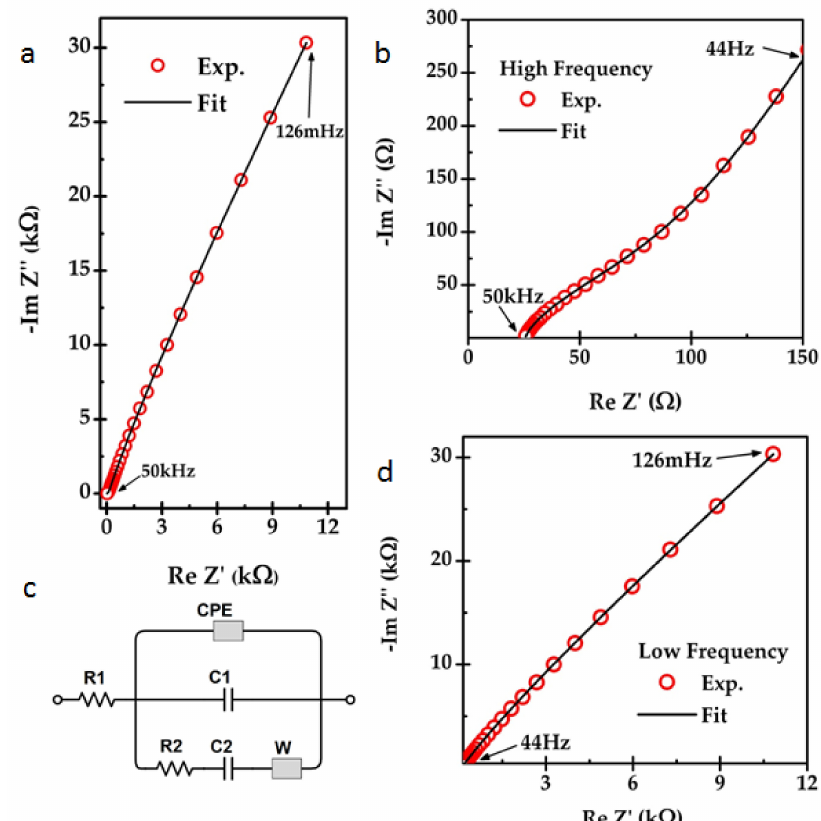
Figure 3. Electrochemical impedance spectroscopy (EIS) analysis results for LPEG in the BMP-FAP electrolyte. ( a ) Full-frequency fitted Nyquist data. ( b ) Prepared equivalent circuit. ( c ) High-frequency fitted Nyquist data. ( d ) Low-frequency fitted Nyquist